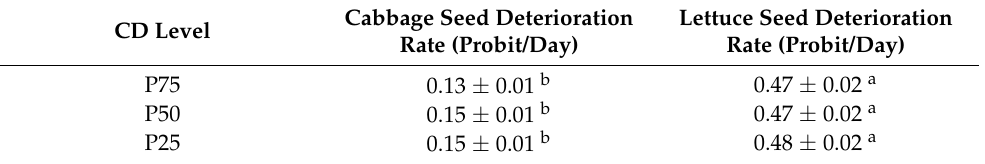
Values represent the mean ± SD (2 trials) of the rate of viability loss in cabbage ( B . oleracea ) and lettuce ( L . sativa ) seeds subjected to controlled deterioration. Values labelled with different letters are significantly different ( p < 0.05, t -test) when compared across species within each CD